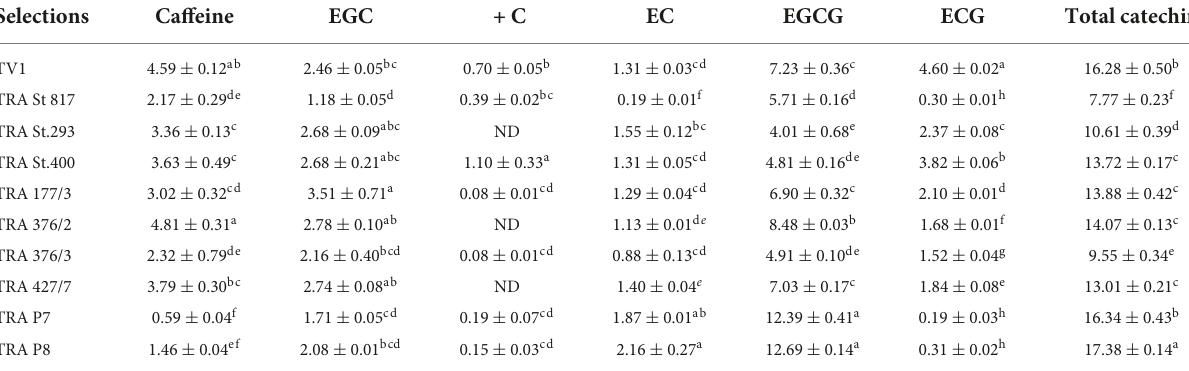
TABLE 2 Catechin and caffeine content (%) in green and purple colored leaves of tea